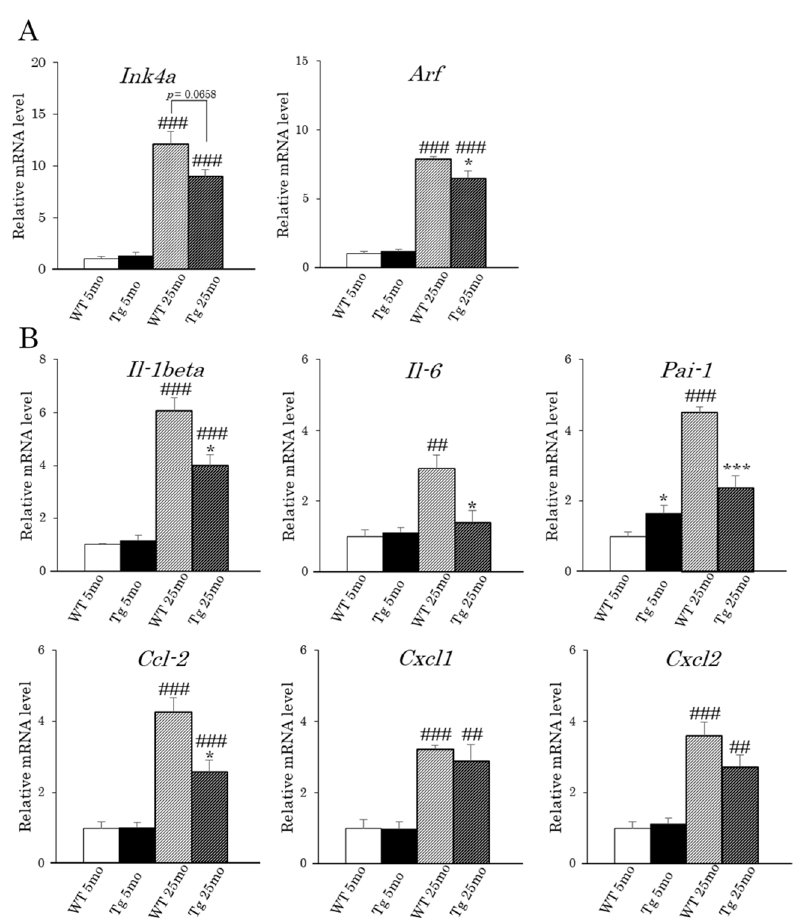
Figure 5. mRNA expression of cellular senescence-related genes in the kidney of aP2-CREG1-Tg mice. ( A ) mRNA levels of Ink4a and Arf . ( B ) mRNA levels of SASP-related genes ( Il-1beta, Il-6, Pai-1, Ccl-2, Cxcl1, and Cxcl2 ). Total RNA isolated from kidneys was analyzed by real-time PCR. Data are means ± SEM ( n = 4–5). * p < 0.05, *** p < 0.001 vs. WT at the same time point; ## p < 0.01, ### p < 0.001 vs. 5 months for the same